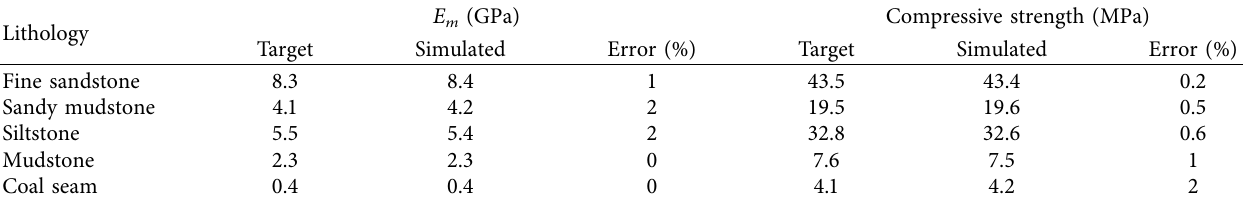
Table 3: Comparisons of the target and simulated elasticity modulus and compressive strengths.